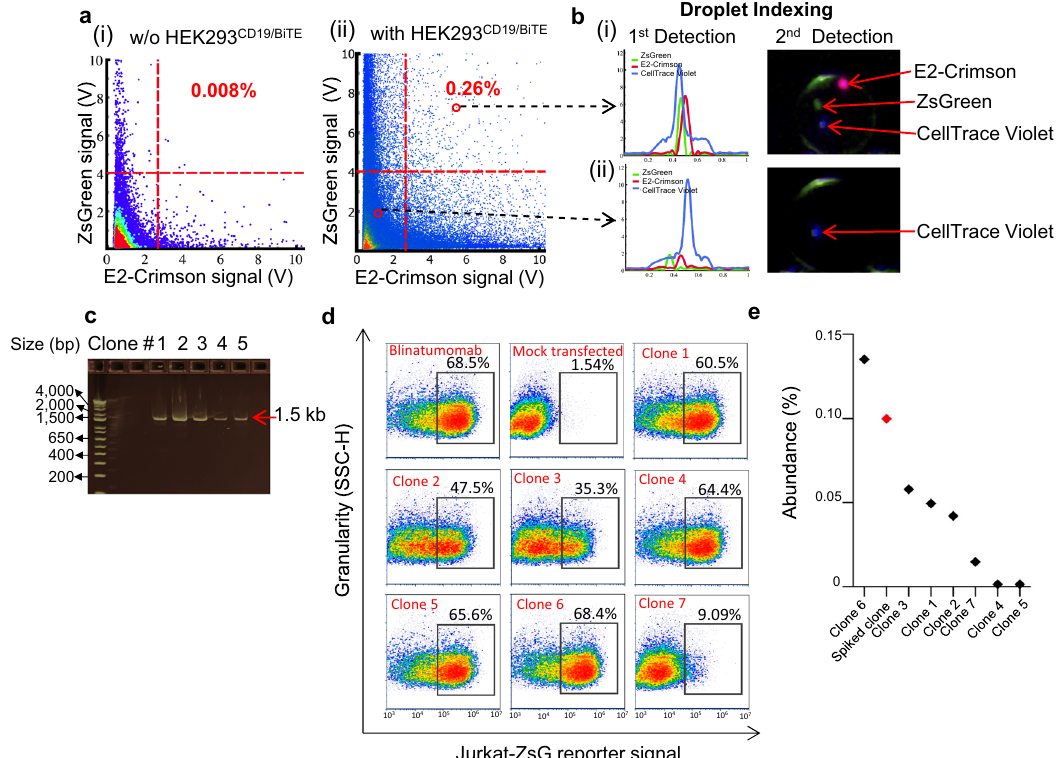
Fig. 5 Functional screening of the complex BiTE cell library HEK293_LP CD19/BiTE spiked with 0.1% HEK293_LP CD19/Blin using a double-reporter based orthogonal assay chemistry on the single cell screening platform. a Representative scatterplots from two independent screening runs showing detected droplet signals after 6-h incubation. Jurkat-ZsG and Jurakt-E2C reporter cells were co-encapsulated without the BiTE library cells (i) or with the BiTE library cells (ii). HEK293_LP CD19/BiTE was pre-labeled with CellTrace TM Violet dye. Gating zones and activation rates are also shown. b Representative droplet signal (PMT) pro fi les and images corresponding to a positive cell (i) and negative cell (ii): HEK293_LP CD19/BiTE cell (CellTrace TM Violet, blue), an activated Jurkat-ZsG cell (ZsGreen, green), and an activated Jurkat-E2C cell (E2-Crimson, red). c Representative DNA agarose gel image showing single-cell PCR products from a panel of isolated CD19xCD3 BiTE clones. d Representative fl ow cytometry plots for bulk functional validation of seven recovered BiTE clones (obtained from two screening runs). Jurkat-ZsG reporter cells were co-cultured with CD19 + Raji in the presence of a day-3 condition medium harvested from the 1-mL-scale expression from Expi293F TM cells transfected with BiTE gene harboring expression plasmids. After 24-h incubation, the Jurkat-ZsG reporter cells were pro fi led by fl ow cytometry to measure the activation rate. Blinatumomab-BiTE was also transfected and expressed in parallel as a positive control. A total of 265 BiTE clones were tested for functionality using Jurkat-ZsG reporter activation assay (only seven clones are represented here). e Estimated abundance of select sequence-veri fi ed recovered BiTEs. Note that Clones 4 and 5 are extremely rare (~0.001% abundance). The abundance estimation is based on individual clones ’ respective counts in the NGS sequences, assuming that these clones are proportionally ampli fi ed during the NGS library